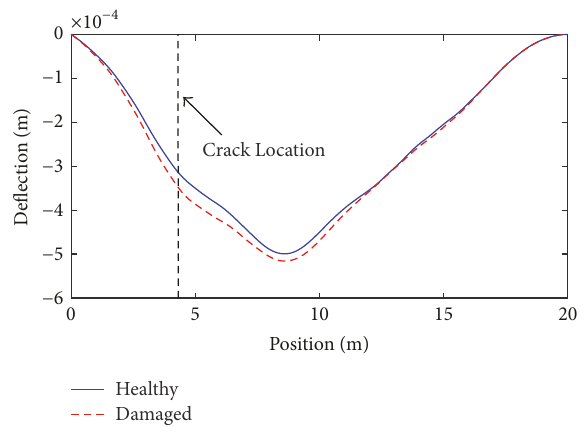
Figure 5: Cross section of the contour plot at line D (moving reference).